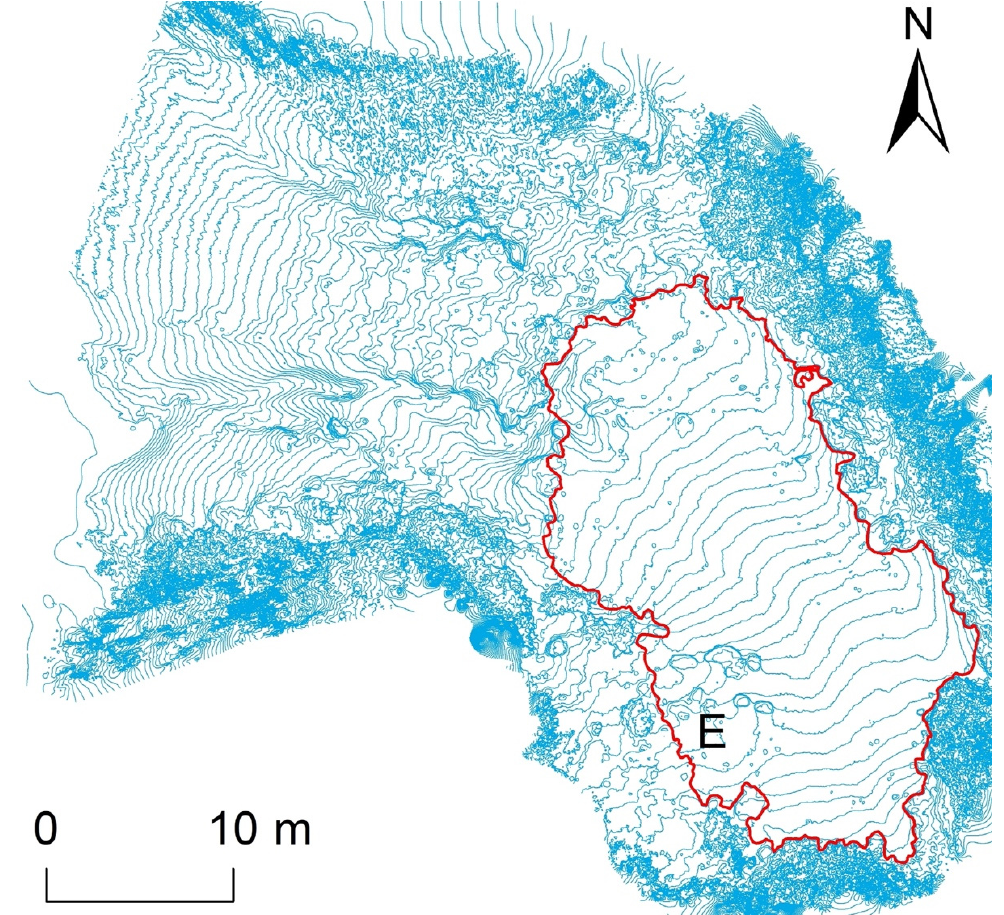
Figure 12. The Kuro-dake campsite in Daisetsuzan National Park (The image was created using photographs taken by a drone on 29 September 2019, contour interval = 10 cm). The line denotes the campsite’s